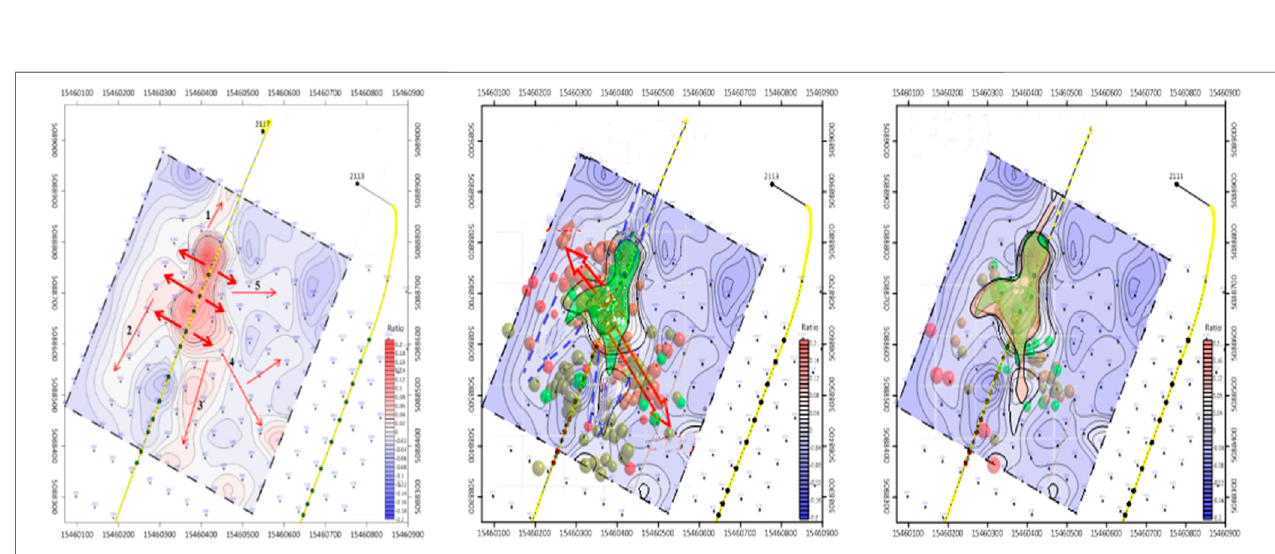
FIGURE 11 | Electromagnetic monitoring of the fracturing fl uid migration direction in well M7 (left) , comprehensive analysis of the temporary plugging of old fractures in the M7 well (middle) , comprehensive analysis of temporary plugging of the fi rst stage in the new seam of the M7 well (right) .